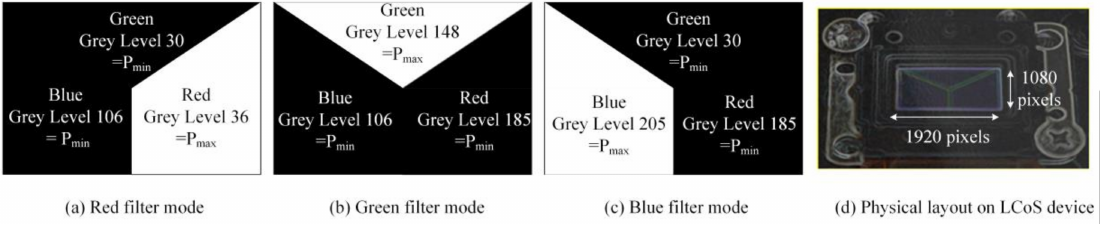
Figure 3. Design of LCoS-based SLM as tunable filter.